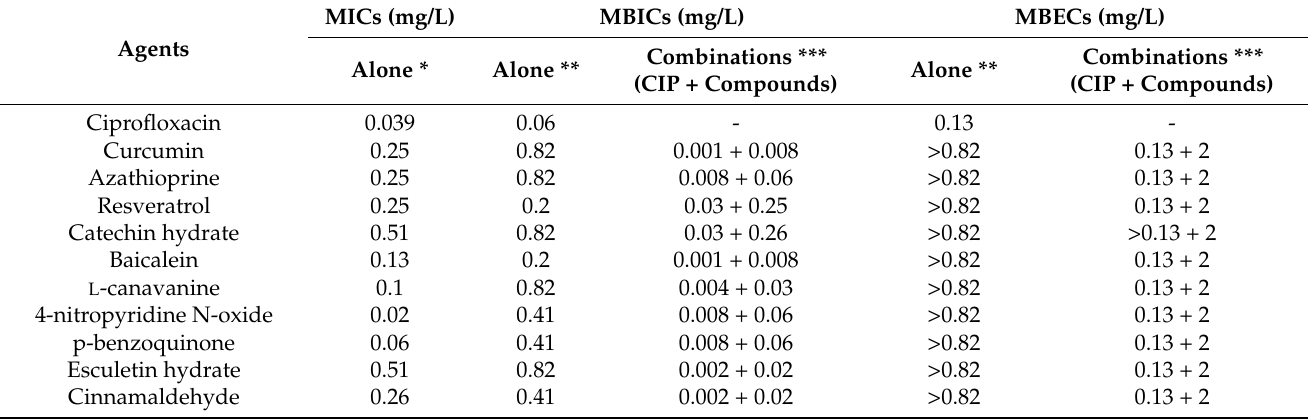
Table 1. MICs, MBICs, and MBECs of the compounds and ciprofloxacin against P. aeruginosa PAO1.